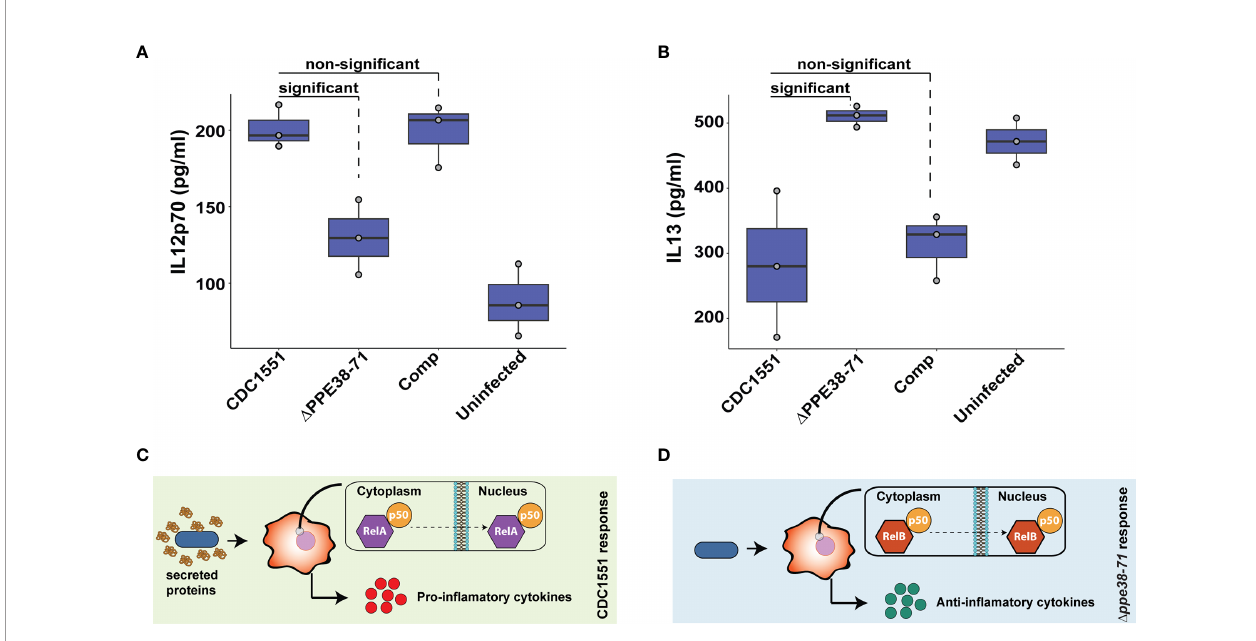
FIGURE 8 | Interleukin-12p70 and IL-13are differentiallysecretedbyTHP-1 macrophage-likecellsat48 hours post-infection. Thelevelsof IL-12p70 (A) andIL-13 (B) in supernatants ofTHP-1macrophage-like cells infectedwitheither M. tuberculosis CDC1551, D ppe38-71 or complemented strainsanduninfectedmacrophages were determined byELISA. Data isrepresentative ofthree biological replicates andsigni fi cantdifferencesweredeterminedwithone-wayANOVA as wellasa TukeyHSDpost-hoc test witha q-valuesetat 0.05. Schematicillustrationof aproposed macrophageresponseuponinfectionwith (C) M. tuberculosis CDC1551 and (D) M.tuberculosis D ppe38-71